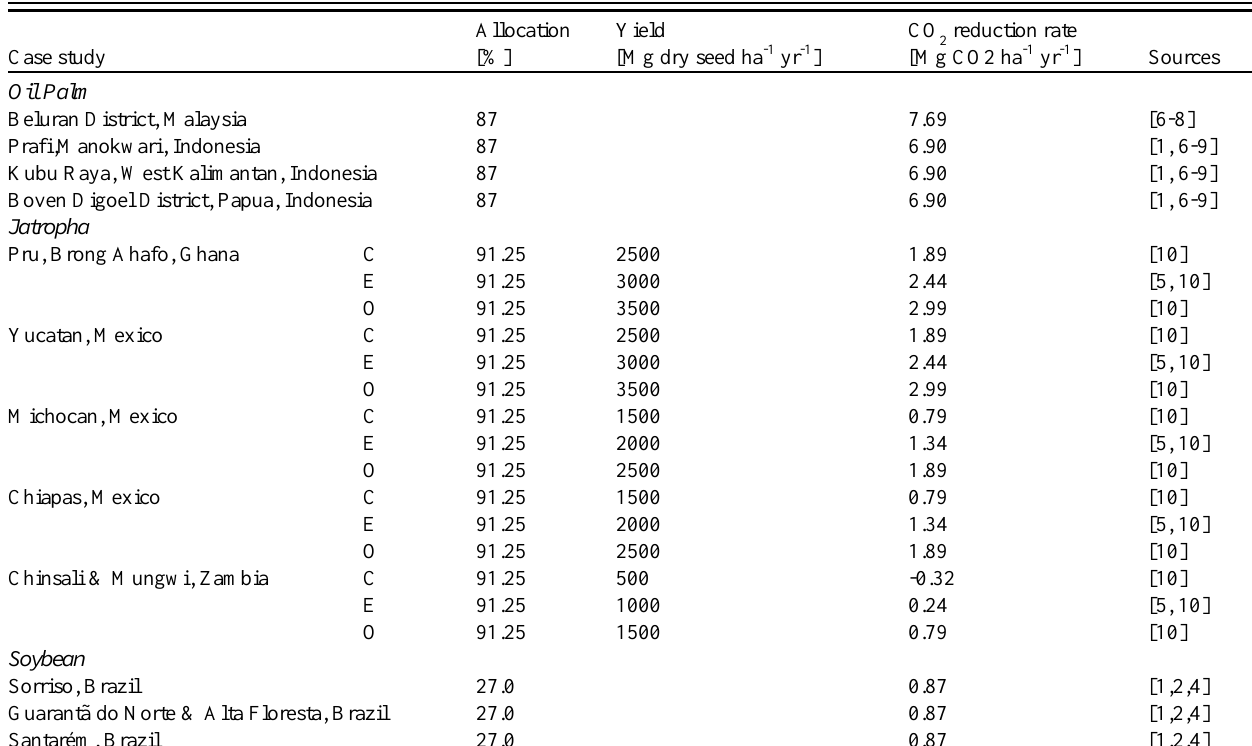
Table 3. Percentage of carbon debt to be allocated to the biodiesels, yield figures used to calculate the CO the CO reduction rates of the biodiesel for each case 2